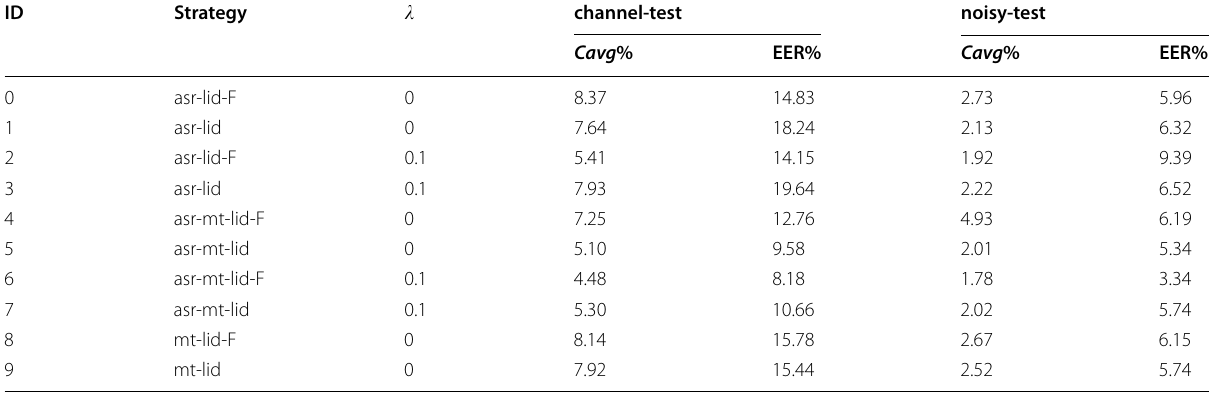
Table 4 Experimental results under different training